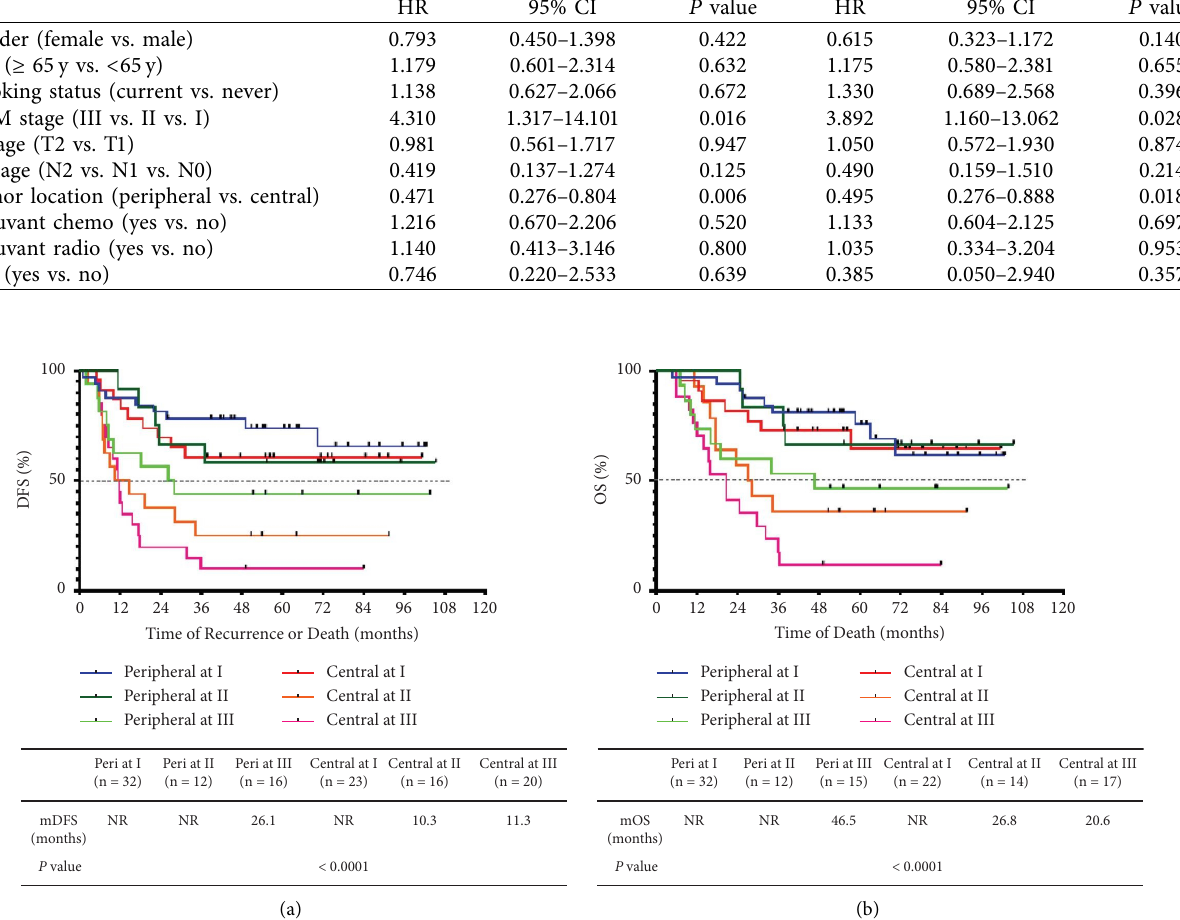
Figure 6: Kaplan–Meier curves of the DFS and OS of resected LS SCLC patients by TNM stage combined with tumor location. (a) Te DFS curves of resected LS SCLC patients by TNM stage (I, II, and III) and tumor location (central and peripheral) (six groups). (b) Te OS curves of resected LS SCLC patients by TNM stage (I, II, and III) and tumor location (central and peripheral) (six